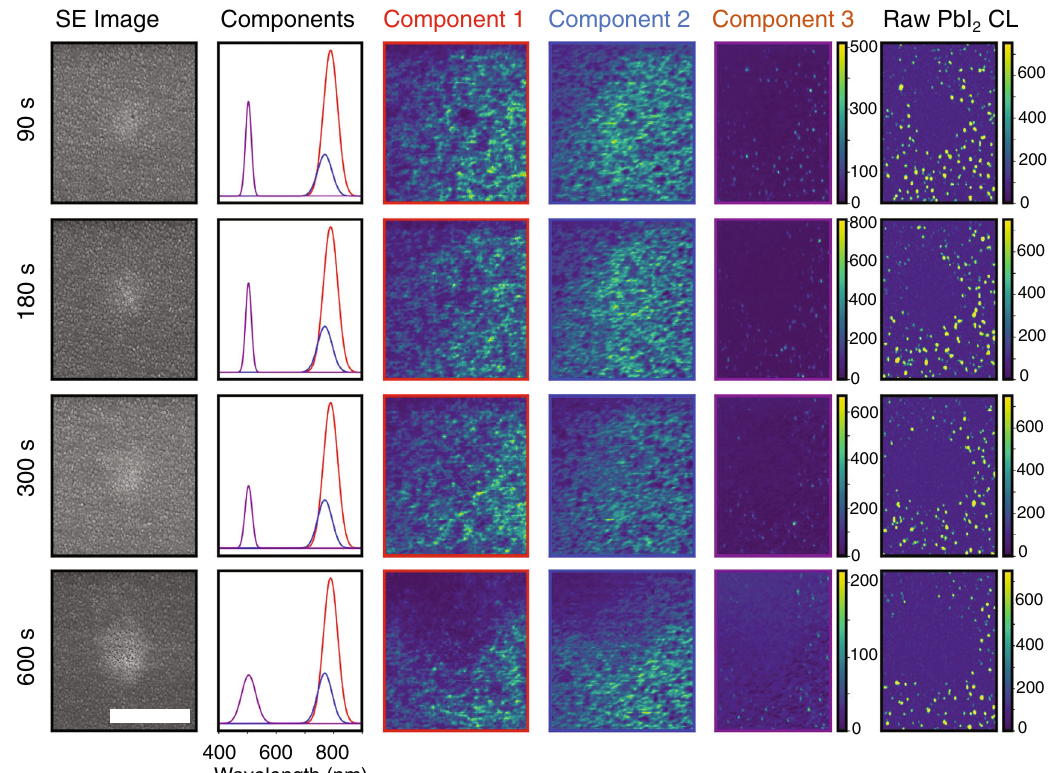
Fig. 4 | Cathodoluminescence analysis of MAPbI 3 fi lm after in situ laser expo- sure. Correlated SE images ( fi rst column) and CL NMF decomposition (columns 2 – 5)afterexposuretoa495-nm,100- μ Wfslasersourcefocusedtoa5- μ mspotsize for laser exposure times of 90 – 600s. Three spectral components are used in the NMF decomposition to highlight the MAPbI 3 exciton CL (component 1; red), the